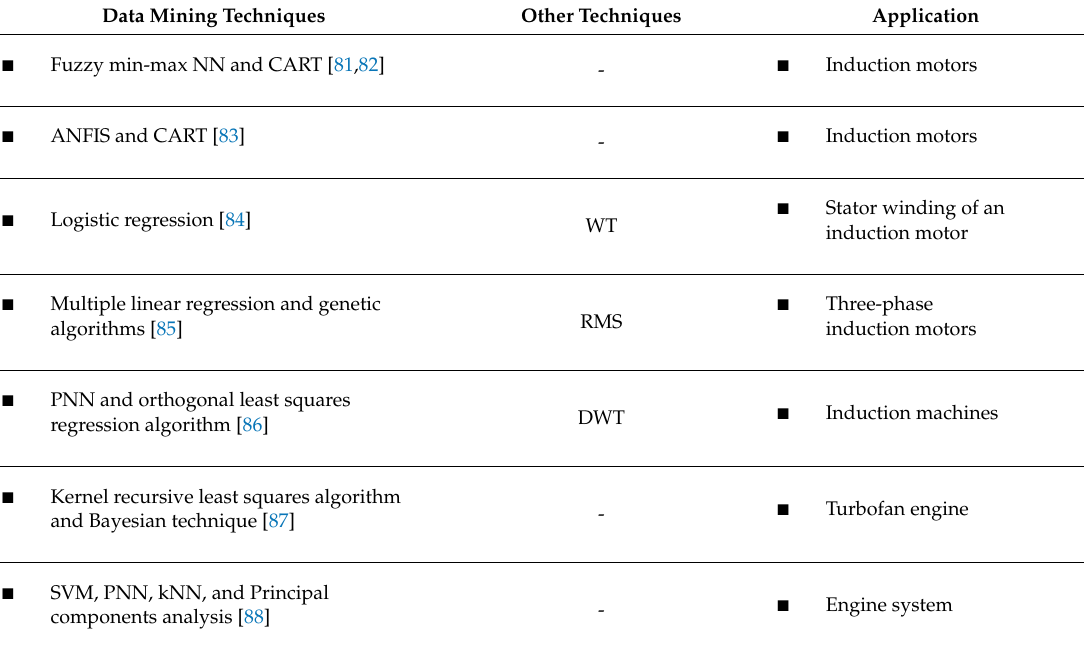
Table 3. Summary for hybrid techniques